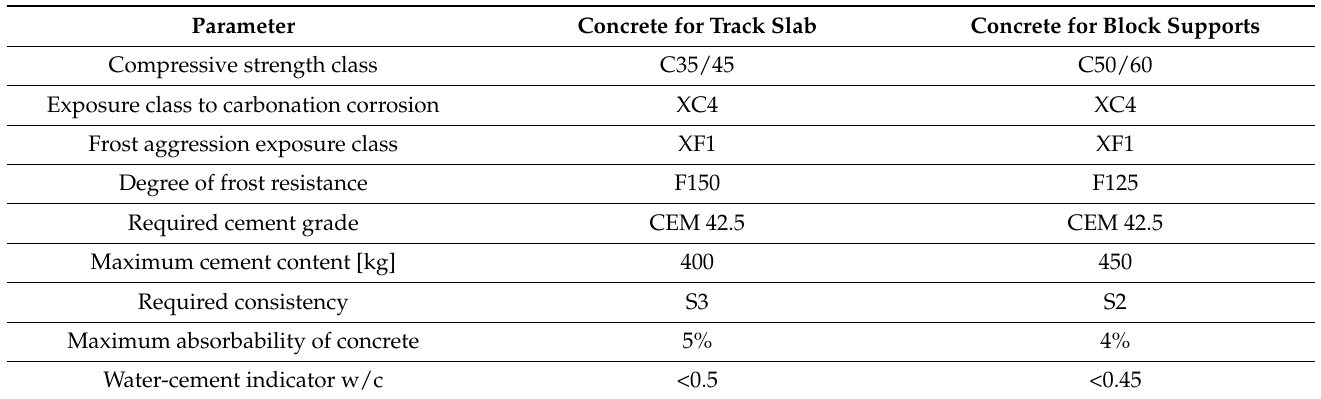
Table 2. Assumptions for concrete mixes.